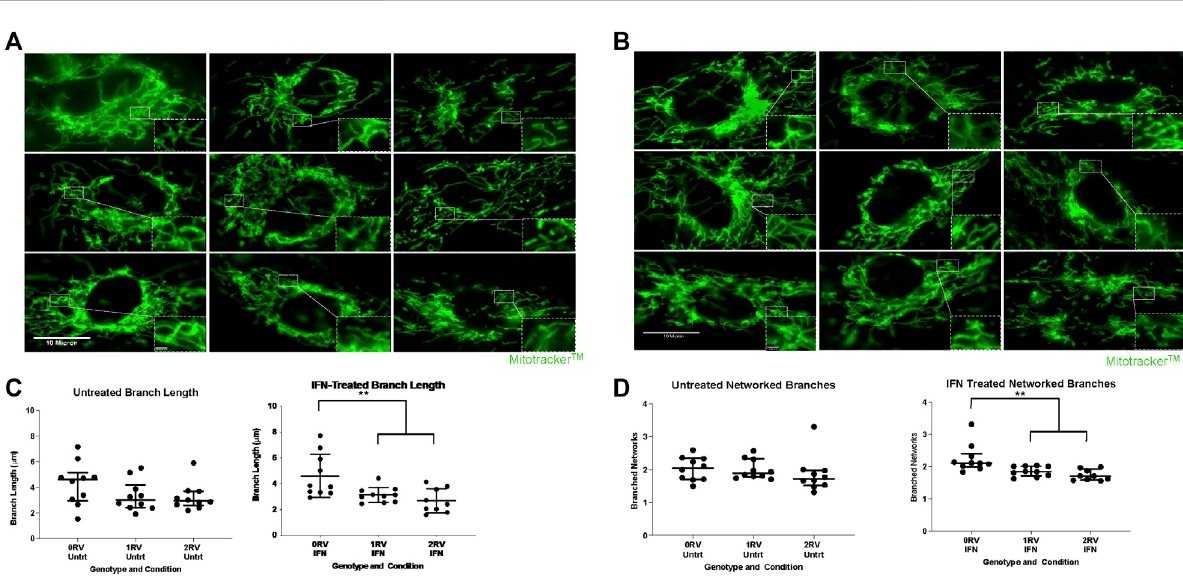
FIGURE 3 Assessment of mitochondrial structure in resting and stimulated HUVECs using MitoTracker, a fl uorescent proxy of ultrastructure. Assessment of mitochondrial structure in resting and stimulated HUVECs using MitoTracker fl uorescent mitochondria stain. (A , B) Mitochondrial structure including branch length and networking are shown in HUVECs representing each genotype, 0 risk variant (0RV left columns), 1 risk variant (1RV middle columns), and 2 risk variants (2RV right columns) were either left untreated (A) or exposed to IFN ɣ 50 pg/ml (B) for 18 h. Representative immuno fl uorescence (MitoTracker green stained) images are shown. Ten cells per genotype and condition were measured; in total aggregate data from 12 HUVEC donors and 4 experiments were analyzed. (C , D) Quanti fi ed mitochondrial branch length (C) and networked branches (D) by APOL1 genotype and exposure condition ( x axis) using the Mitochondrial Network Analysis (MiNA) tools available in the FIJI distribution of ImageJ. Mitochondrial length was measured in microns ( μ M). Each additional risk variant associated with a reduced degree of mitochondrial networking; and effect that became statistically signi fi cant across the genotypes upon treatment with IFN ɣ . p -values were calculated using Kruskal – Wallis test for cross genotype comparisons. p < 0.01 is indicated by